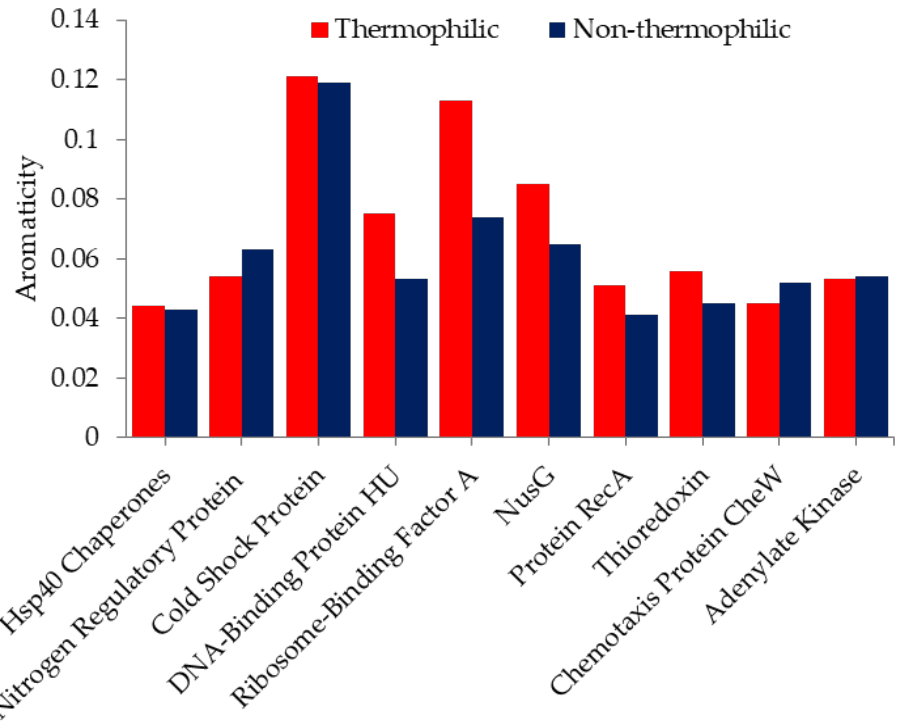
Int. J. Mol. Sci. 2022 , 23 , x FOR PEER REVIEW Figure 2. Aromaticity values of thermophilic proteins and non-thermophilic orthologous. The secondary structure is a folded structure formed by hydrogen bonds between partially positive hydrogen atoms and partially negative nitrogen atoms in the backbone [60 – 62]. Common secondary structure elements include coil, helix, sheet, and turn. The secondary structures of all 10 pairs of proteins are shown in Figures 3 and 4, and their percentage is represented in Table 1. Table 1. Percentage of secondary structures in thermophilic (Ther) and non-thermophilic (non-Ther) proteins. Helix (%) Sheet (%) Coil (%) Turn (%)